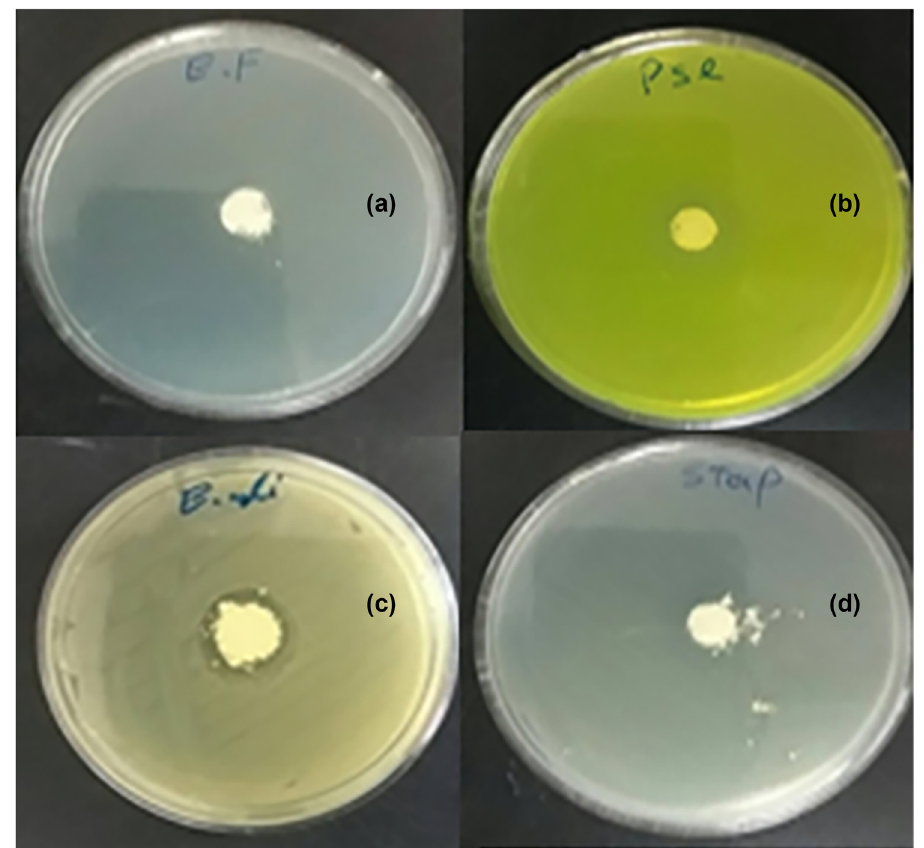
Figure 5: Created clear zones around the holes pored with the fabricated ZnO NPs in the plates that were inoculated with Enterococcus faecalis ( a ) , P. aeruginosa ( b ) , E. coli ( c ) , and S. aureus ( d ) .